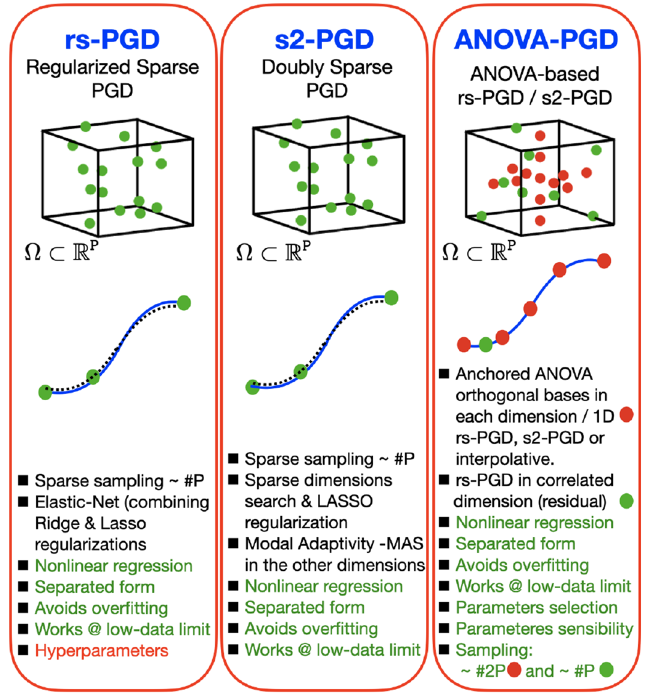
Fig. 2 Part B. Non-intrusive MOR techniques with the main sampling and approximation features, their pros (emphasized in the green text) and the cons (in